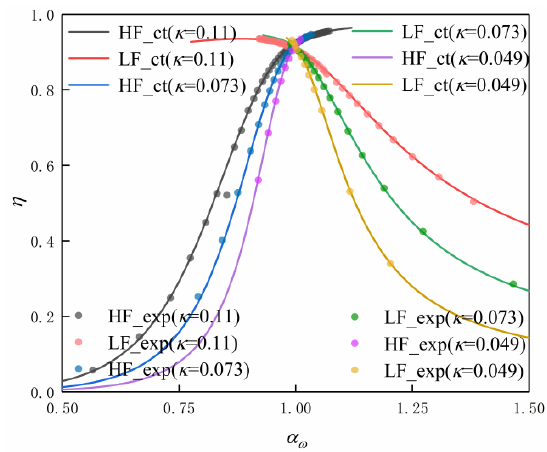
Figure 10. Transfer efficiency versus α ω at detuning where HF_ct, LF_ct, HF_exp and LF_exp mean theoretical high-frequency, theoretical low-frequency, experimental high-frequency and experimental low-frequency, respectively.